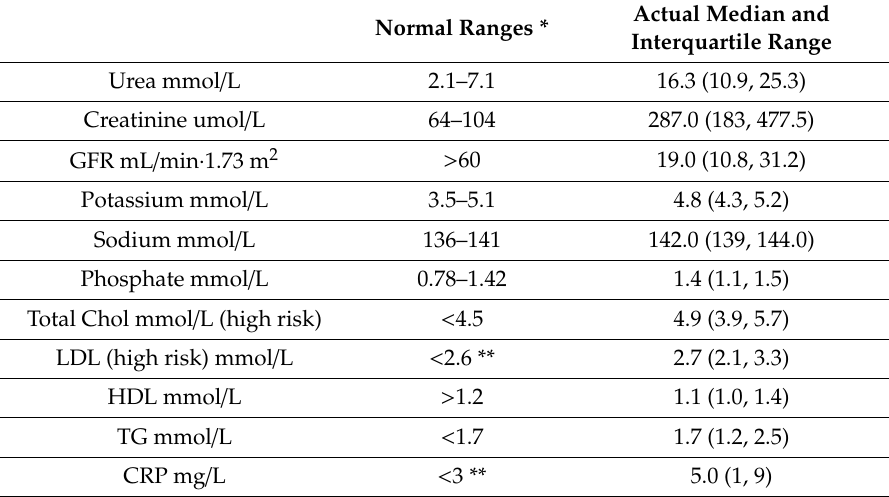
Table 5. Biochemistry profile of participants. Actual Median Normal Ranges *